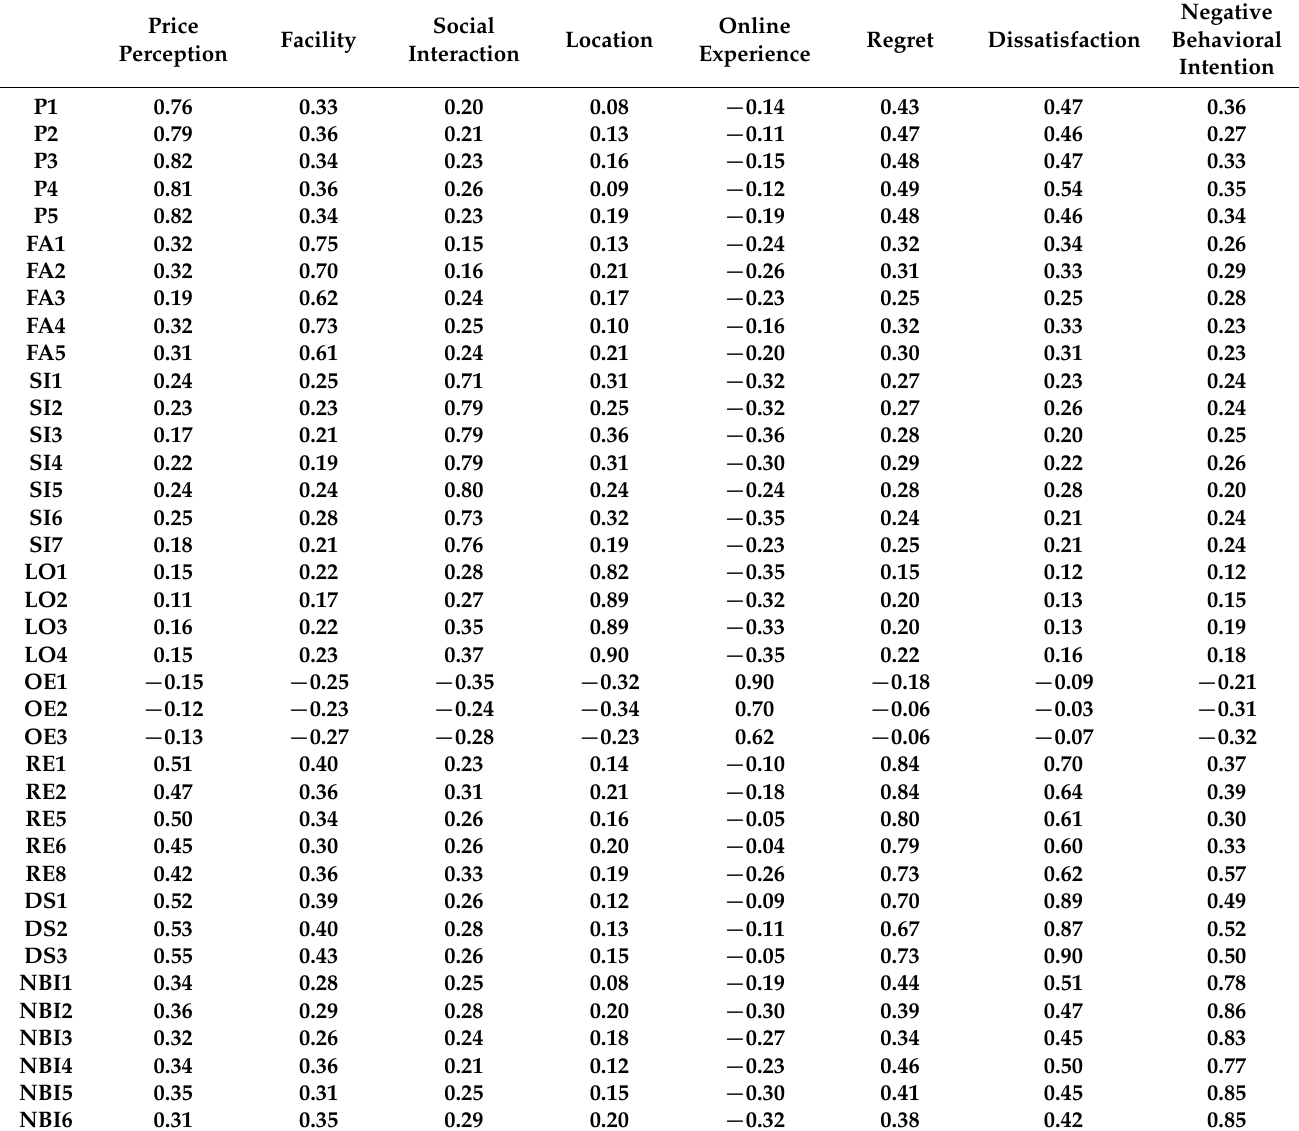
Table 4. PLS confirmatory factor analysis for discriminant and convergent